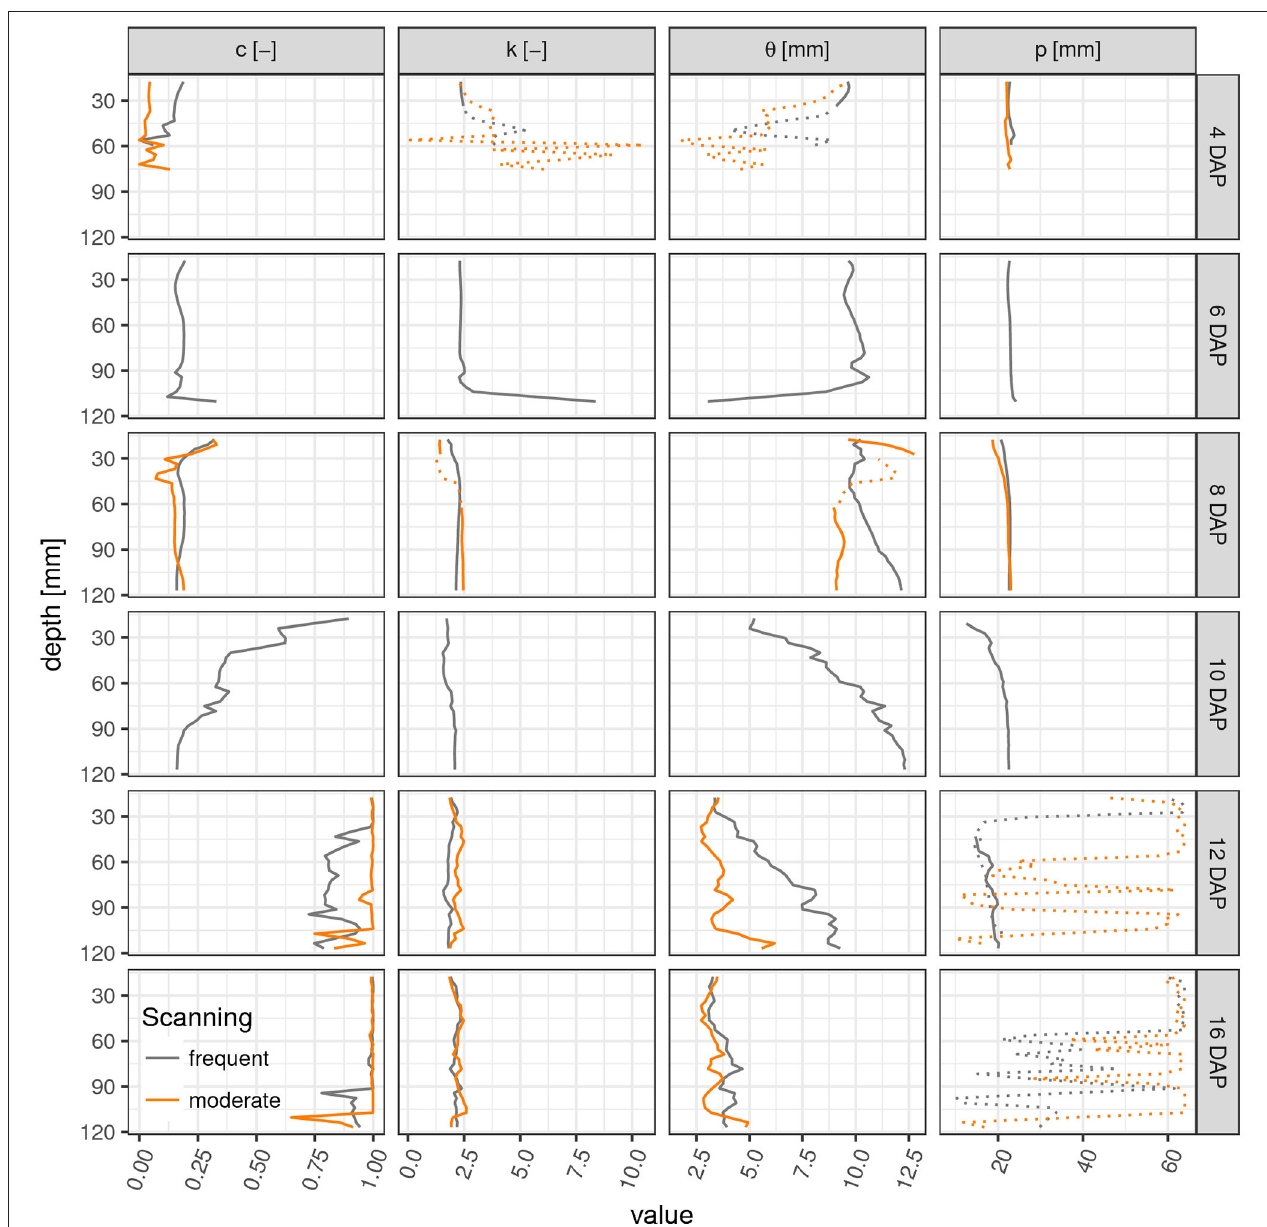
FIGURE 4 | Parameter profiles ( c , weighting factor; k , shape parameter; θ , scaling parameter; p , tap root-wall distance) of the mixed triangular-gamma model at each scan time (days after planting) in equidistant, 5mm thick slices. Dashed lines indicate uncertain values due to imbalanced mixing of the two models in Equation (4) ( c < 0.15 or c >